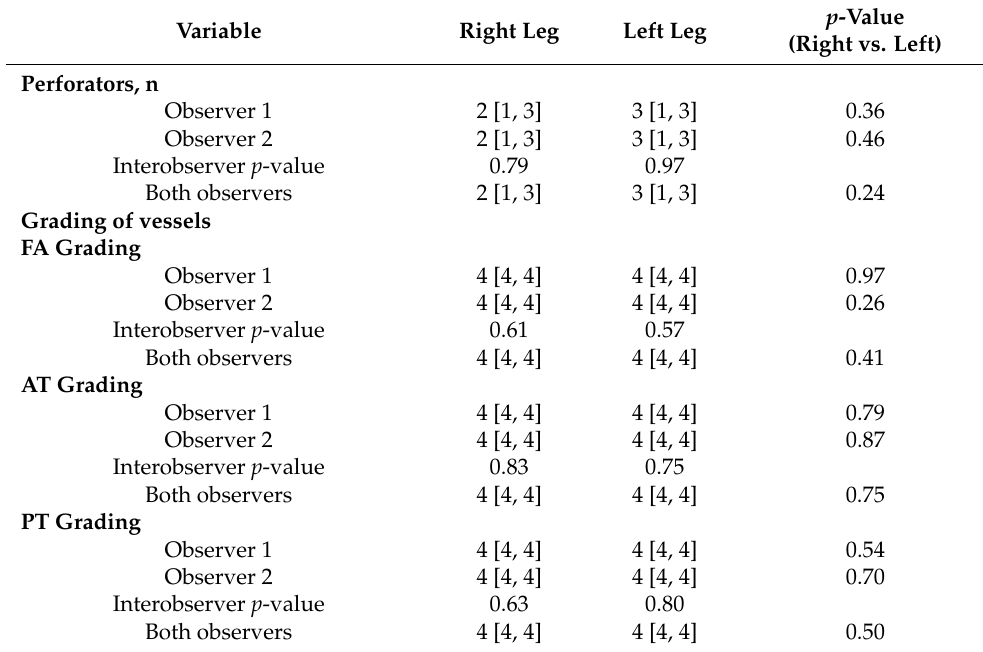
Table 3. Number of perforators and grading of image quality of fibular artery (FA), anterior tibial artery (AT), and posterior tibial artery (PT) determined in lower right and left legs by two observers. The values are given as the median with the interquartile range (IQR); p ‐ values were determined using the Wilcoxon signed ‐ rank test.